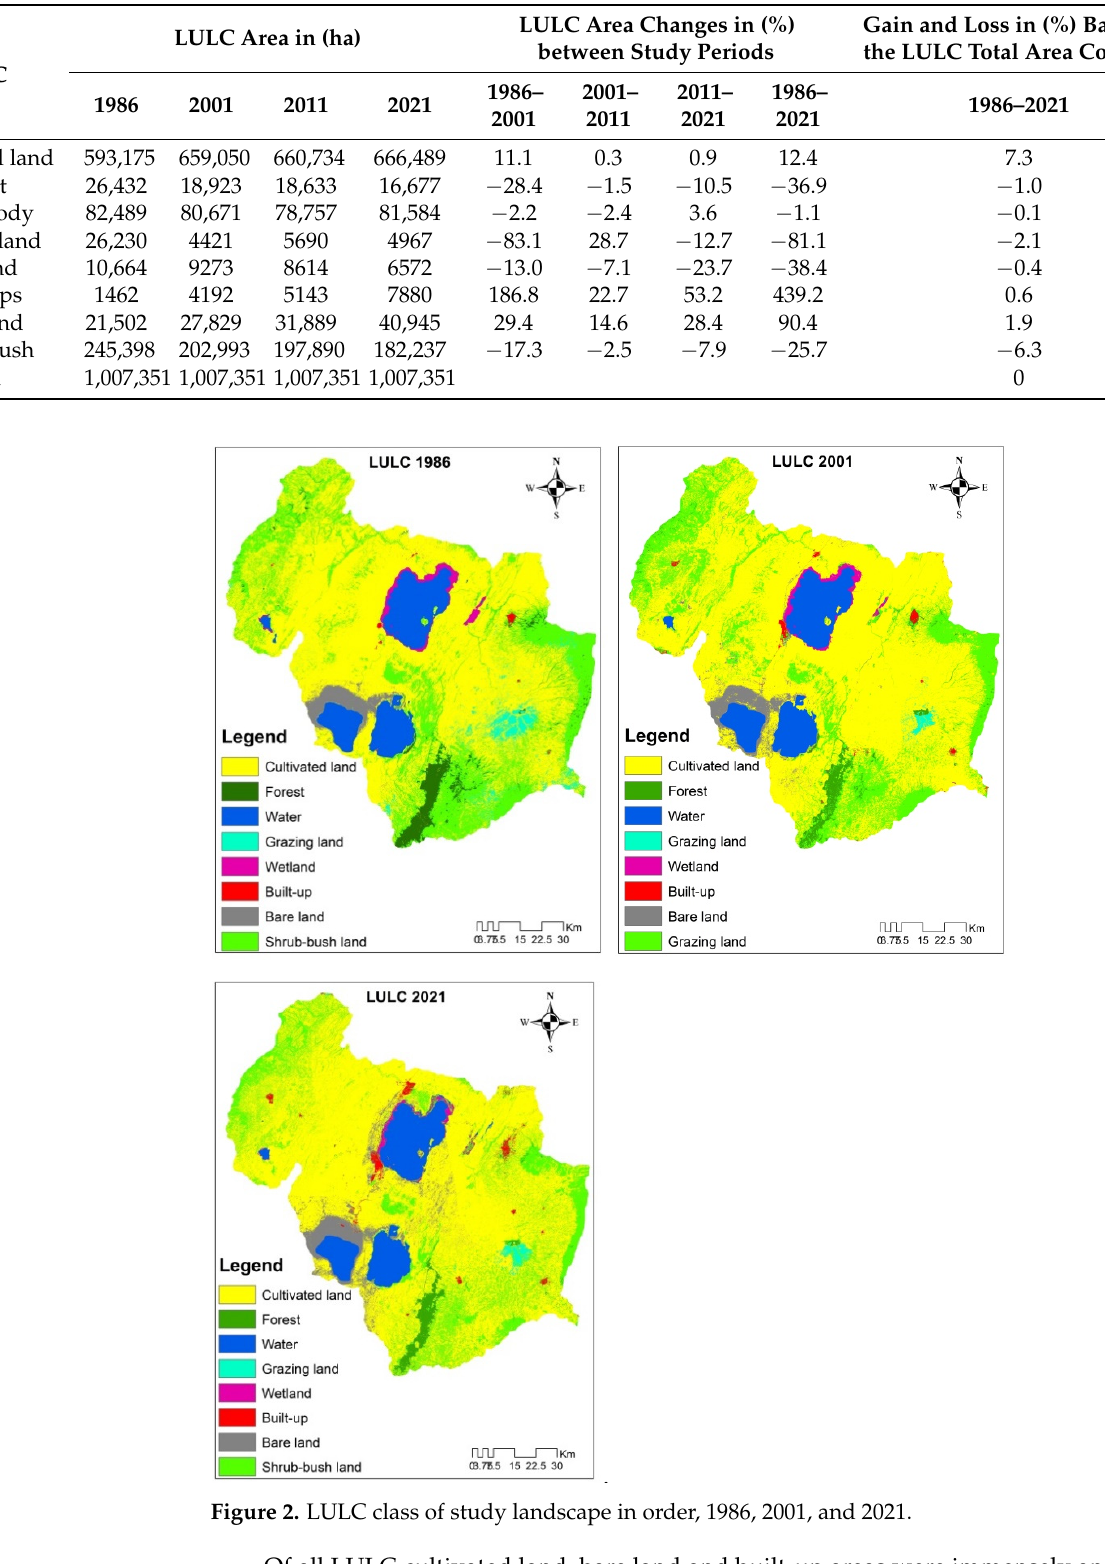
Figure 2. LULC class of study landscape in order, 1986, 2001, and